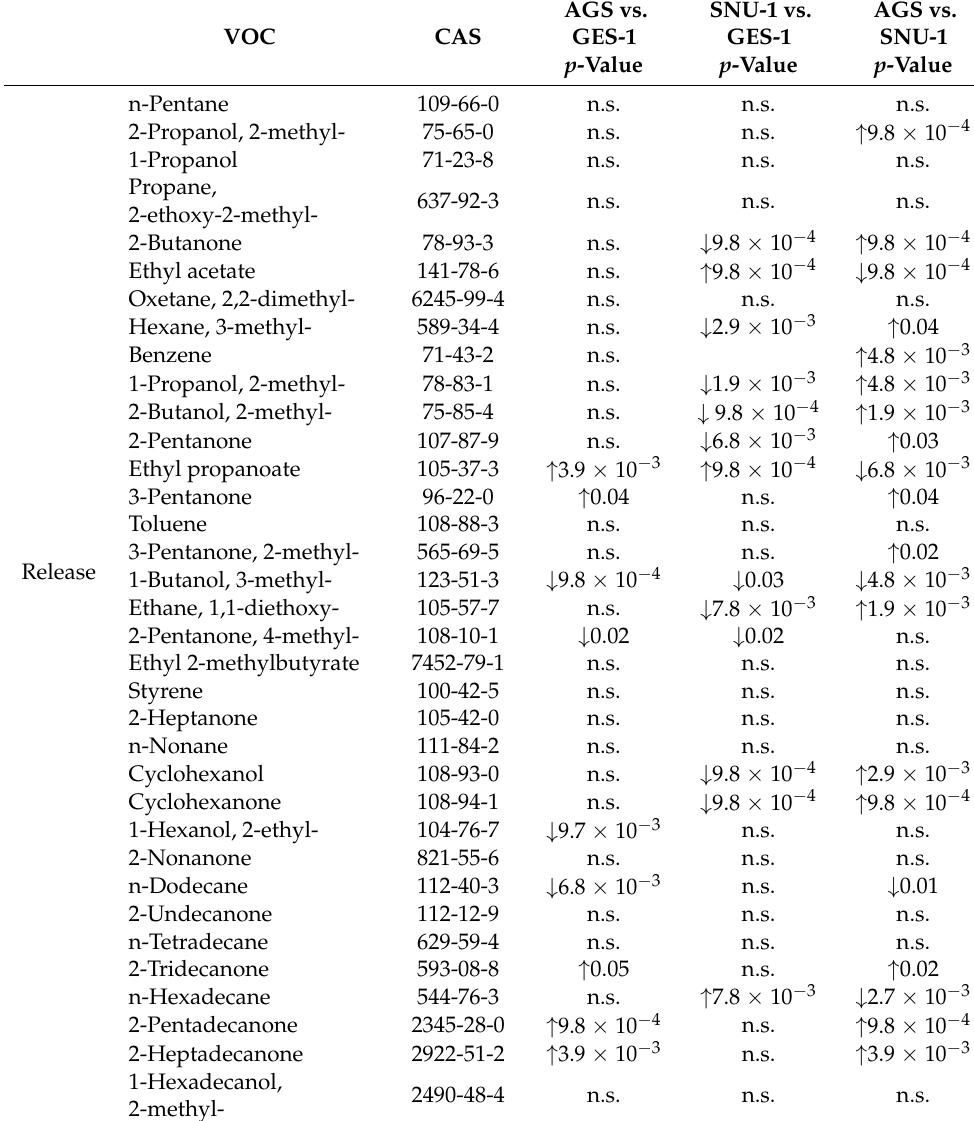
Table 5. Comparison of the emission of VOCs by the cells under study. p -values refer to the Wilcoxon signed-rank test. Compounds in italics were not quantified for reasons mentioned in the text. n.s.: not significant. ↑ upregulated, ↓